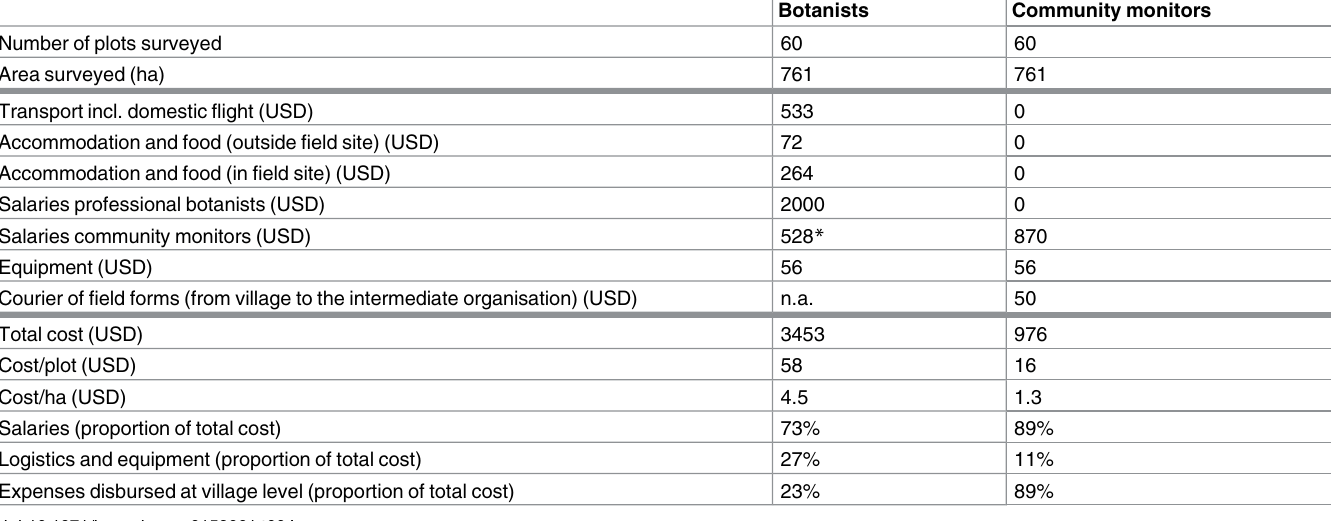
Table 4. Costs of tree species identification in the plot network by professional botanists and community monitors in montane forest in Yunnan, China (in USD). * Two villagers acted as guidesand assistants during botanists’ tree identification.